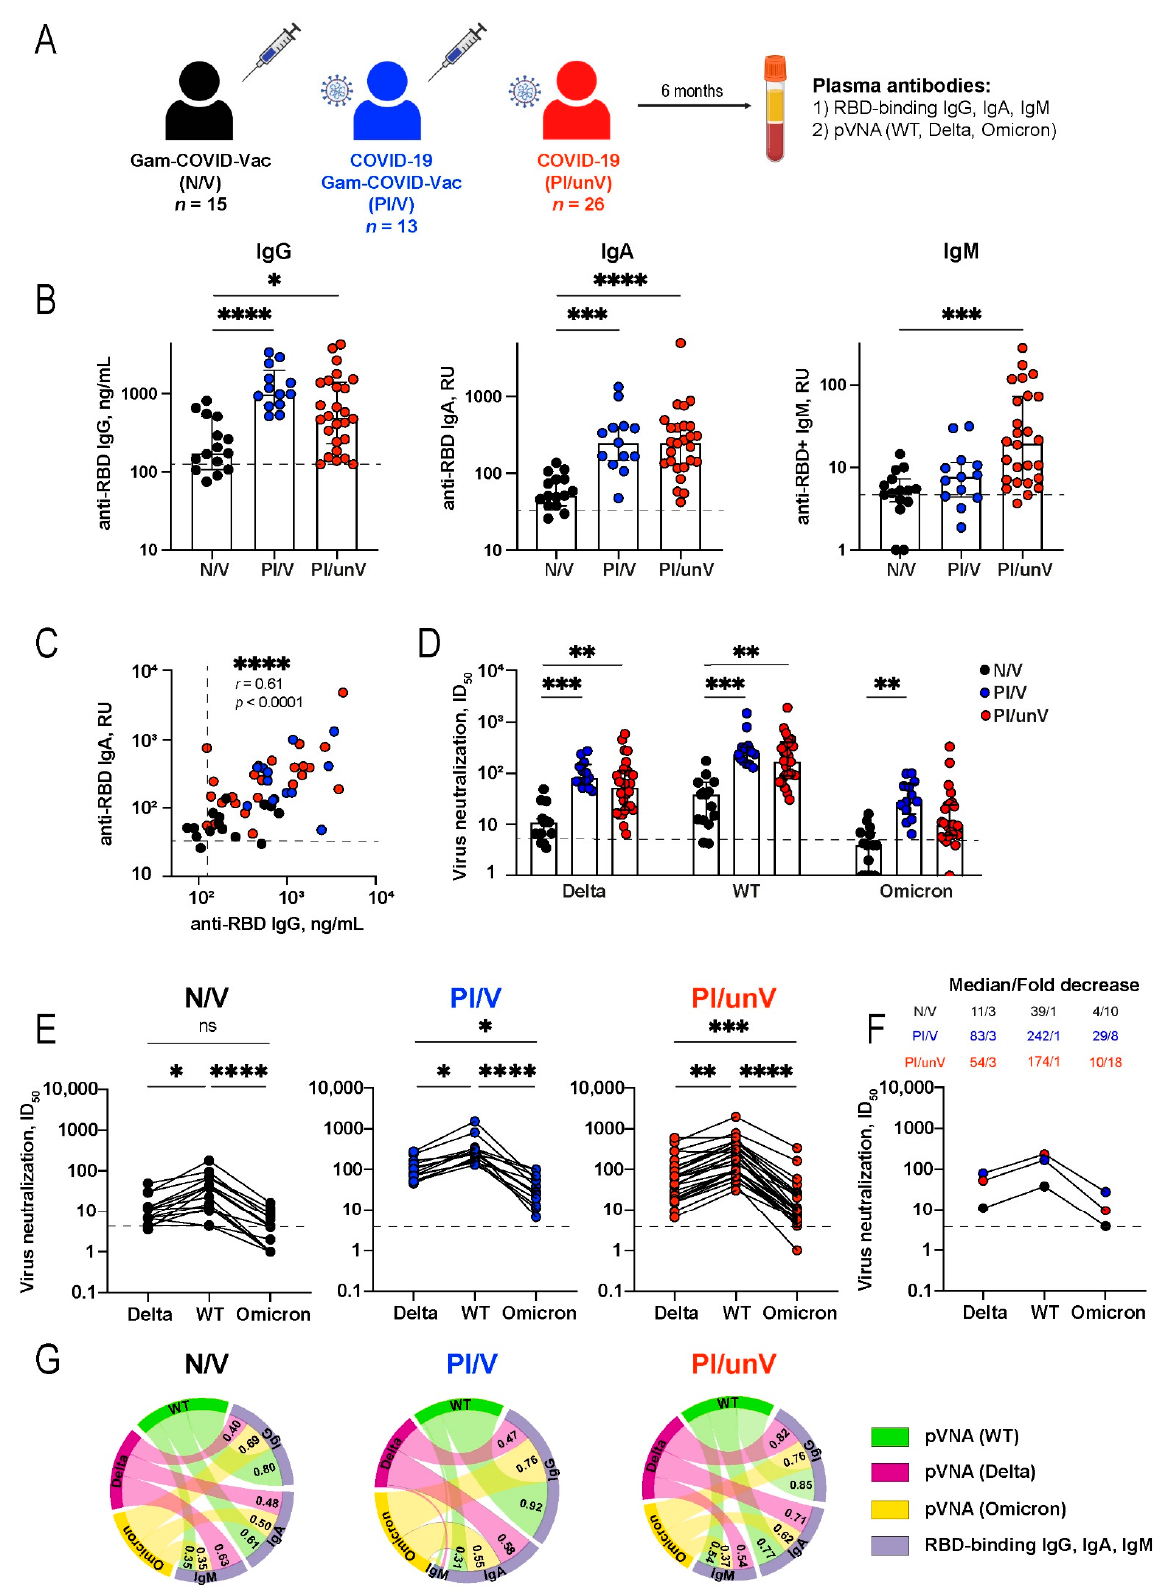
Figure 1. RBD-binding and virus-neutralizing activity of sera from COVID-19 convalescent patients and Gam-COVID-Vac recipients. ( A ) Study design. ( B ) Serum IgG (left panel), IgA (middle panel) or IgM (right panel) antibody binding to SARS-CoV-2 RBD, measured by ELISA. IgA and IgM levels